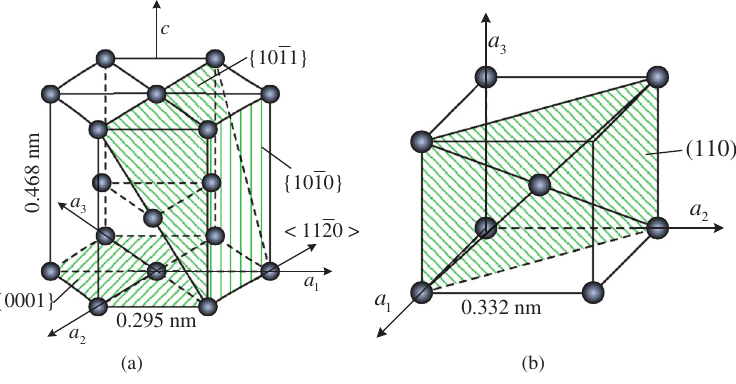
Figure 2 : Unit cells of α - and β -phases: (a) hcp α -phase, (b) bcc β -phase.